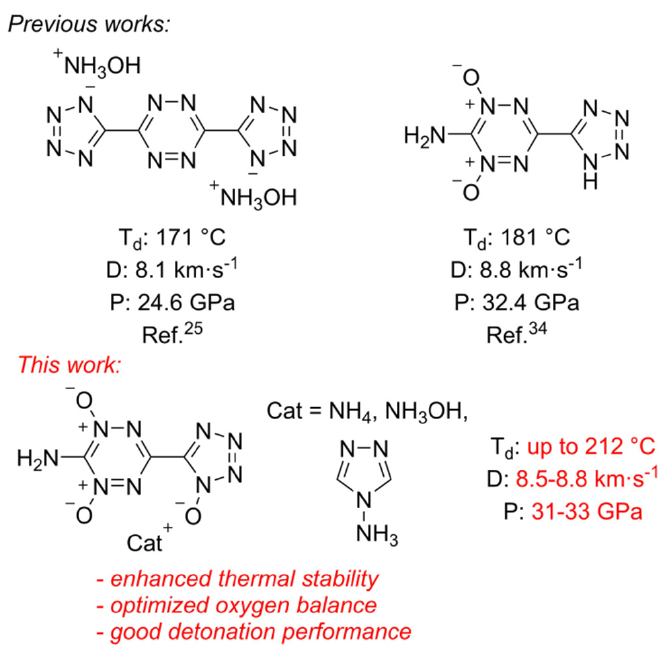
Figure 1. Previously known and newly synthesized energetic materials incorporating tetrazine– tetrazole